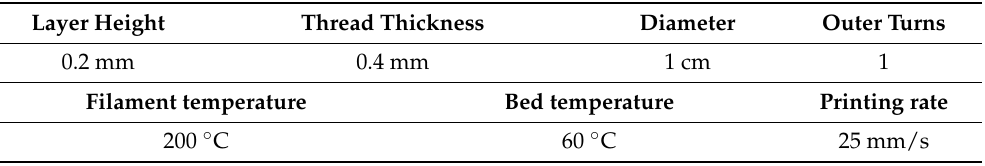
Figure 3. The 3D virtual image ( a ) and photographs ( b ) of freshly printed disks and after being used for the cell proliferation assays. Table 2. Design parameters and printing